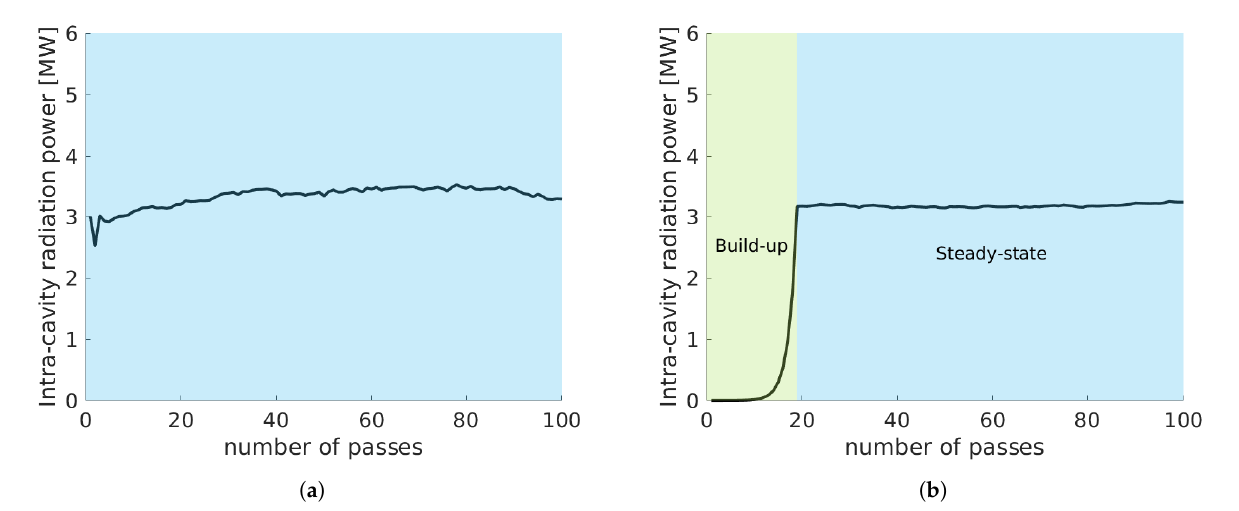
Figure 5. ( a ) Example of the peak power per pass in an oscillator starting with a low repetition rate seed laser. From the first pass already the net gain should be zero. In practice, it takes a few passes for the system to self-stabilize. ( b ) Example of the peak power per pass in an oscillator starting from shot-noise. For 19 passes the build-up regime where the net gain is positive is highlighted with a green color. At pass 19, the desired peak power level is reached and the steady state regime is entered, marked with a blue color. From this pass and onward, the net gain is reduced to zero and the peak power level is maintained in each